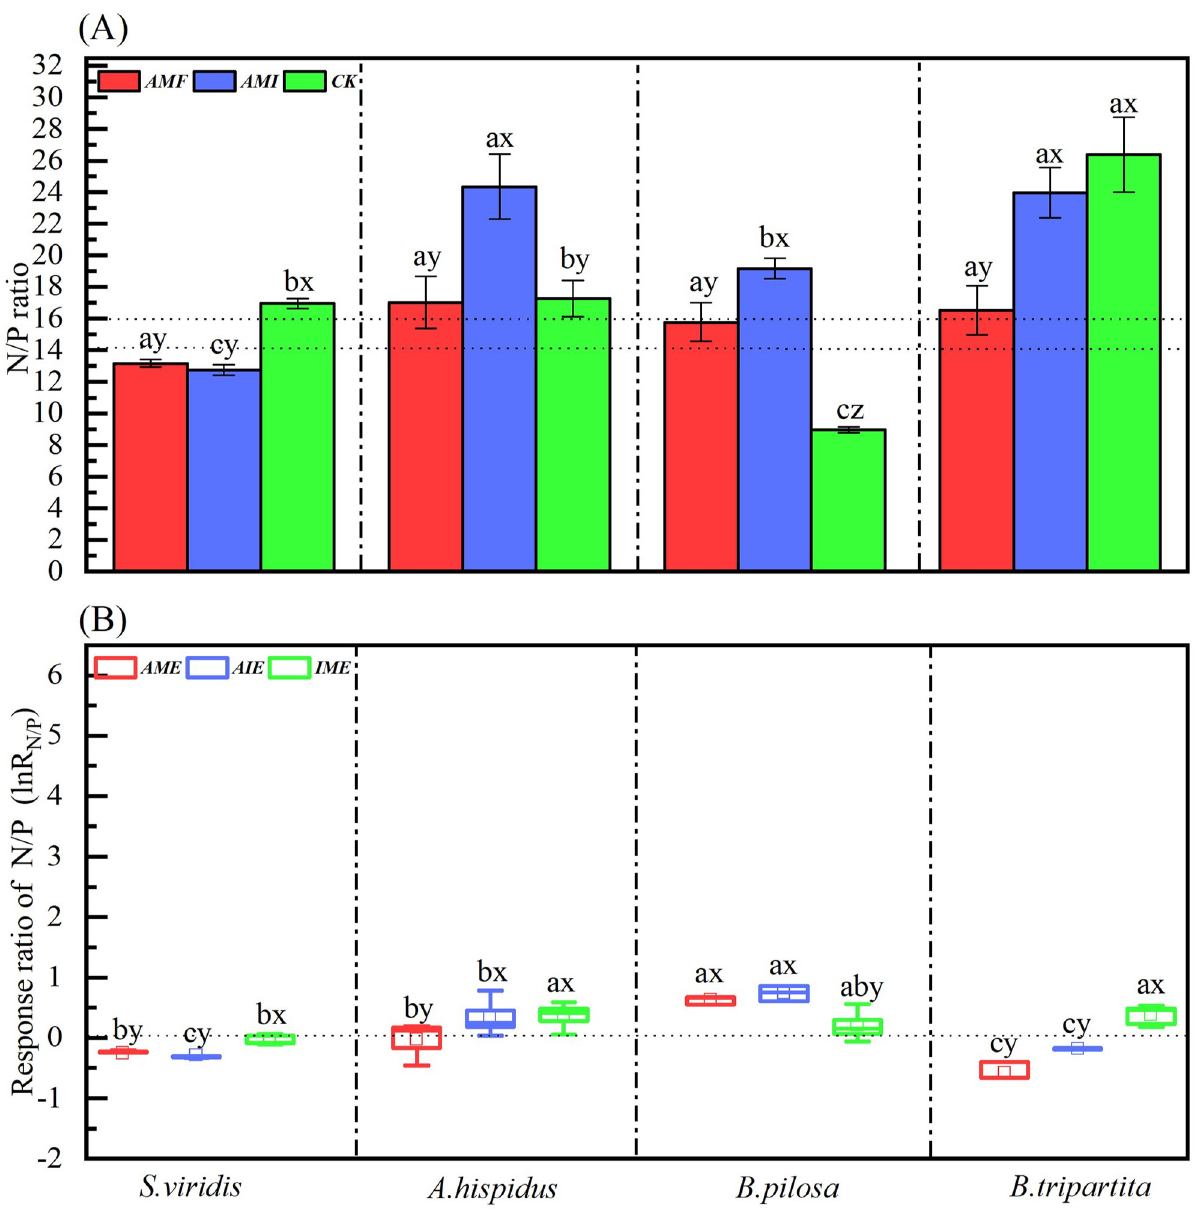
Fig 4. N/P ratio (A) and response ratio lnR N/P (B) of four plant species through the different microbial treatments. The meanings of abbreviations ( S . v , A . h , B . p and B . t ; AMF , AMI , and CK ; AME , AIE and I ME ) and the lowercase letters (a, b, c, d; x, y, z) are the same as in Fig